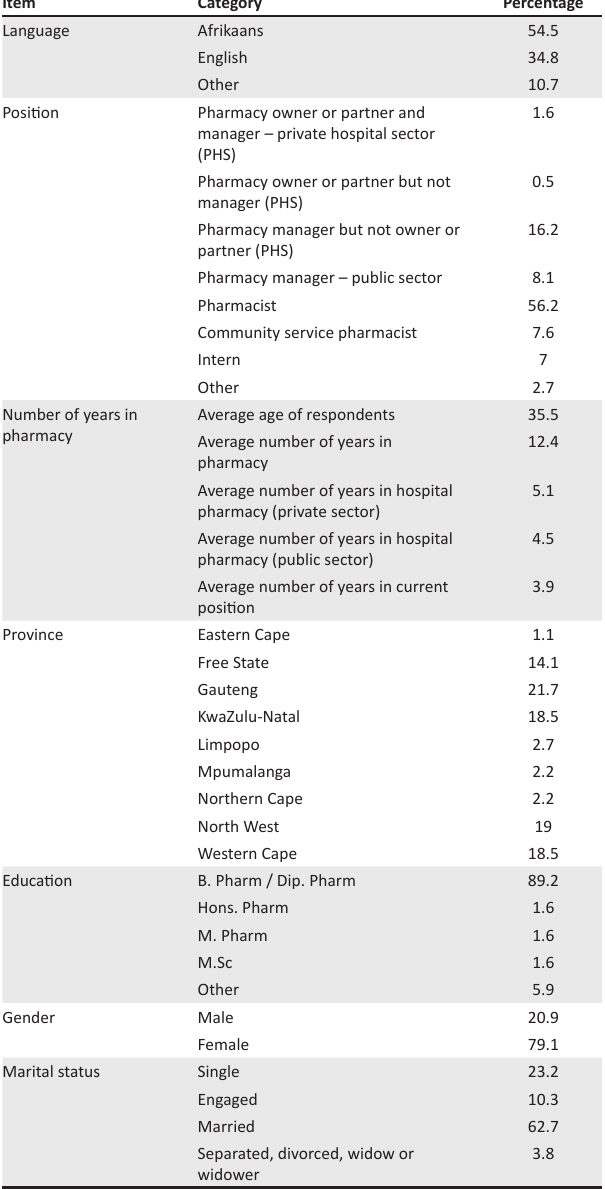
TABLE 1: Characteristics of the